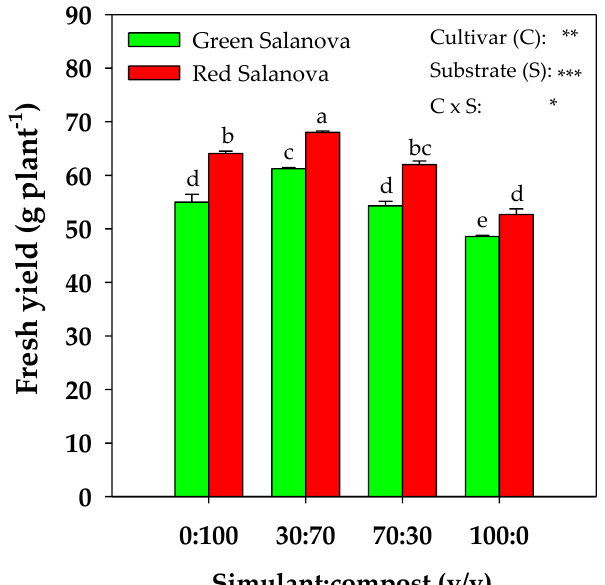
Figure 1. Fresh yield of green and red butterhead Salanova lettuce, as influenced by substrate mixtures (four different rates of Mojave Mars simulant:compost v:v). Different letters above bars indicate significant mean differences according to Duncan’s multiple range tests ( P ≤ 0.05). Vertical bars indicate ± SE (standard error) of means. *, **, *** Significant at P ≤ 0.05, 0.01 and 0.001, respectively.